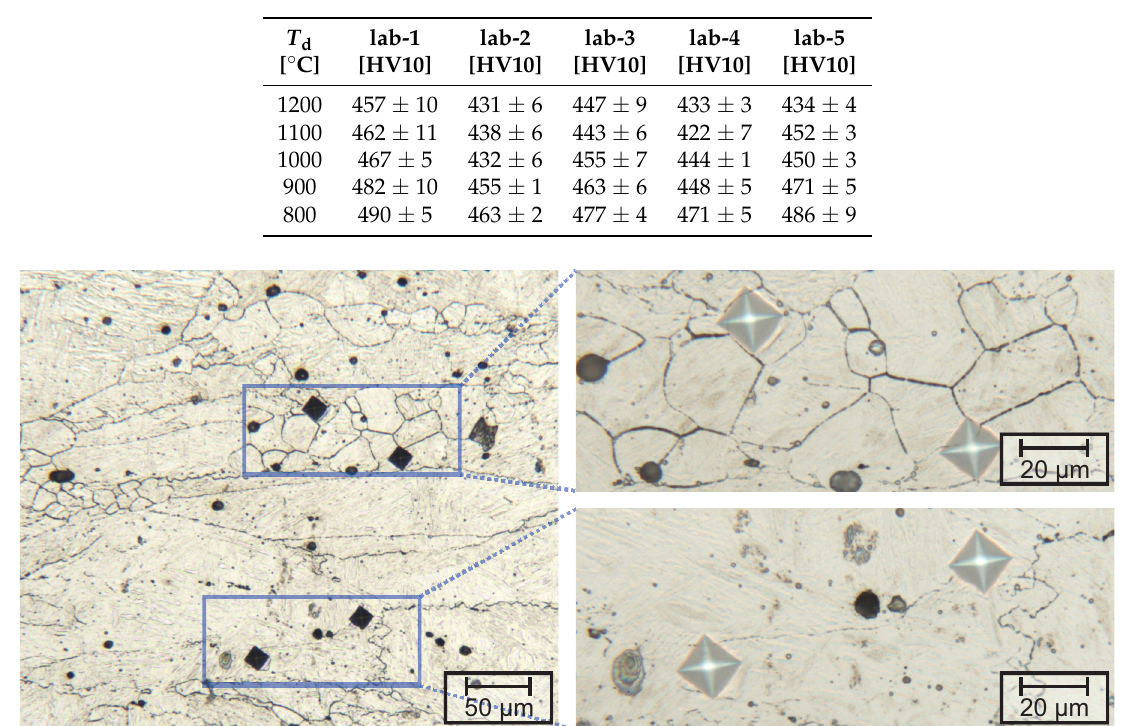
Table 4. Measured Vickers hardness values for the investigated alloys and heat treatments. The mean square error is given as well.